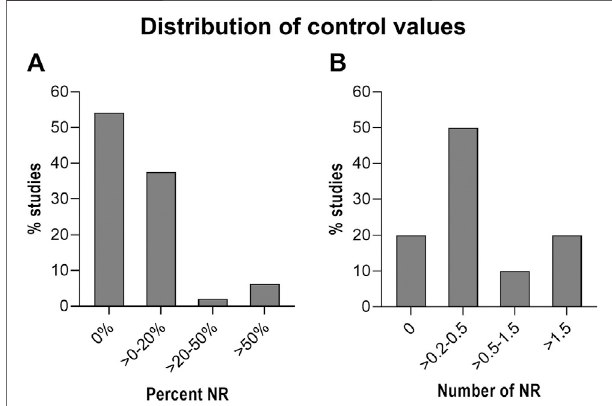
FIGURE 3 | Distribution of Nipple retention (NR) in control rats/groups. Control rats/groups from the 80 studies in Supplementary Table S1 . (A) : Results shown as percent NR in the control groups. (B) : Results shown as number of nipples in the control groups.